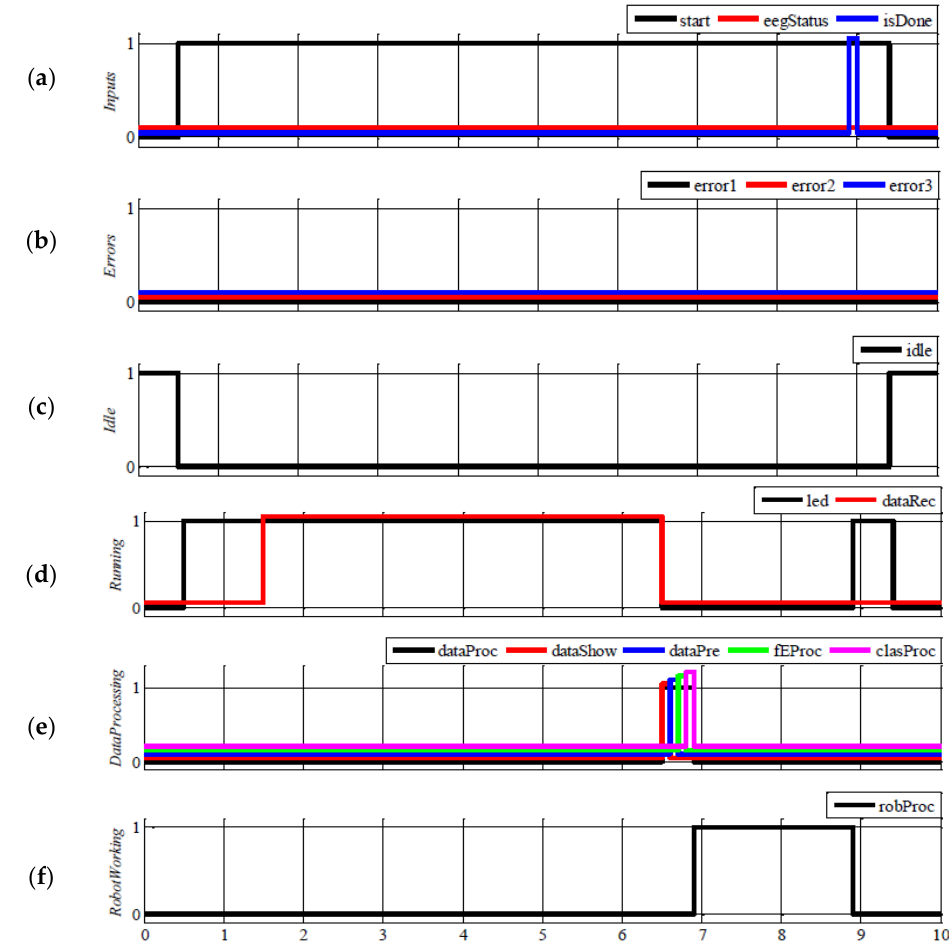
Figure 10. Auxiliary variables for the properly operating state machine scenario, i.e. ( a ) set of Inputs signals entered into the system, ( b ) set of variables Errors, ( c ) Idle state variable, ( d ) Running state variables, ( e ) set of DataProcessing state variables, ( f ) RobotWorking state variable.